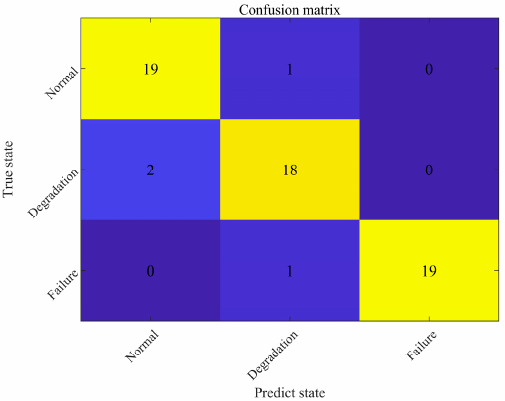
Figure 9. Current diagram under three states.